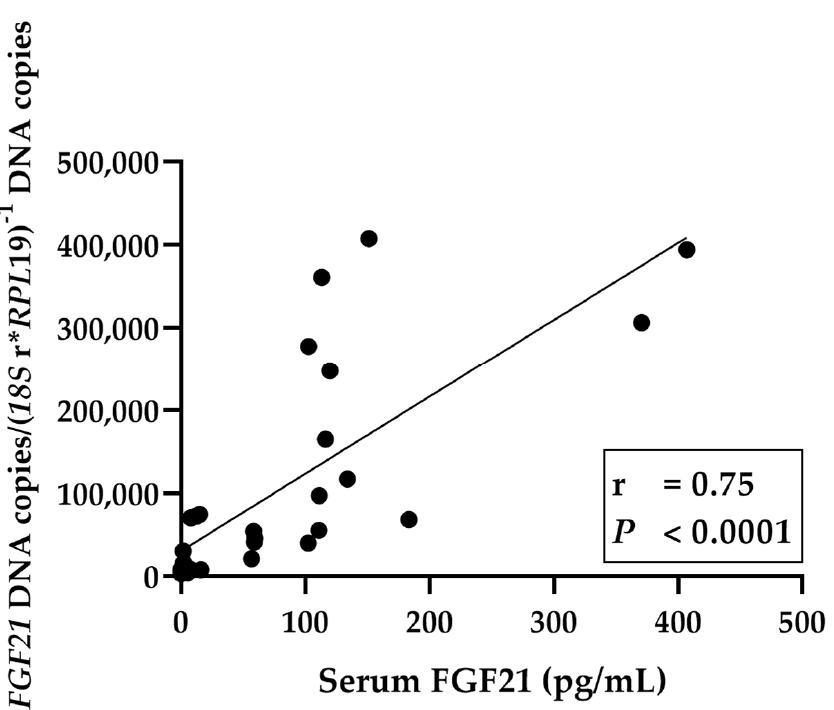
Figure 7. Linear regression of FGF21 DNA expression with serum FGF21 in young goats fed an N- and/or P-reduced diet. The level of significance with Pearson’s correlation coefficient was set at p = 0.05.